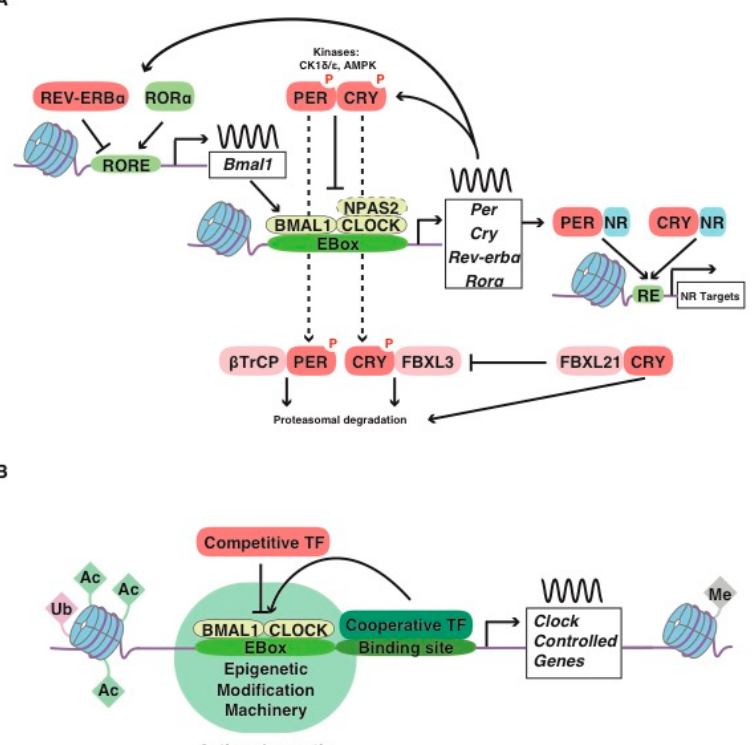
Figure 1. ( A ) Core molecular clock network. The mammalian circadian clock consists of transcription/ translation feedback loops in which the positive limb (CLOCK or NPAS2 and BMAL1) heterodimerizes and activates the transcription of downstream genes, including Per , Cry , Ror α and Rev-erb α . The negative limb proteins (PERs and CRYs) multimerize and inhibit CLOCK/BMAL1. The phosphorylation of the repressors mediated by Casein Kinases 1 ( CK1 ε and CK1 δ ) and AMPK directs these proteins to ubiquitin-mediated proteasomal degradation (which, for CRY1, is regulated by FBXL protein ratios). In a secondary loop, Bmal1 is regulated by the repressor REV-ERB α and its opposing nuclear receptor ROR α , which bind competitively to the shared element RORE, thus repressing or activating the transcription of the Bmal1 gene, respectively (reviewed in [5]). An additional level of circadian regulation exists with CRYs and PERs, which have been reported to bind independently of other core-clock factors to genomic sites enriched with Nuclear Receptor (NR) recognition motifs (response element, RE) [6–9]. Post-translational modifications of core-clock factors can also regulate transcription (e.g., deacetylation of BMAL1 or PER2 by SIRT1 [10,11]). ( B ) Regulation of clock-controlled genes. Cell-type and tissue-specific transcription factors bind to specific enhancers and/or respond to specific environmental signals and to chromatin accessibility (regulated by covalent modifications of DNA and histone tails, including histone acetyltransferases such as CBP [12,13], histone deacetylases such as SIRT6 [14], the histone lysine demethylase JARID1a [15], and the histone methyltransferase MLL3 [16], which activate transcription). Transcription factors can compete for CLOCK/BMAL1 binding (e.g., bHLH-ZIP factor USF1 [17], inflammatory factor NF- κ B [18], nuclear receptor HNF4A [19], MYC oncogenic factor [20] or through chromatin remodeling (for example the recruitment of the HDAC3 co-repressor by REV-ERB α to regulate BMAL1 binding [21]) or through cooperative effects (lineage-determining transcription factors such as PDX1 [22] or hypoxia-induced HIF1 α act synergistically with BMAL1 [23]), thus potentiating or inhibiting the metabolic outputs.